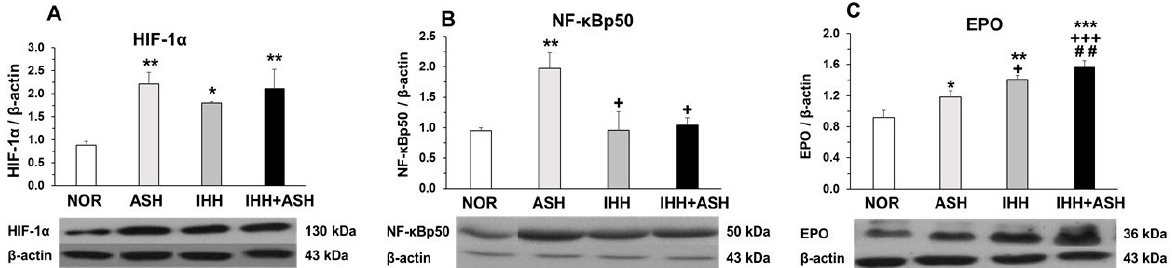
Figure 3. Transcriptional factors in response to hypoxia. Examples of Western blots bands normalized to β -actin (with each corresponding well) are shown. Units are expressed relative to the β -actin content. ( A ) HIF-1 α , hypoxia-inducible factor 1-alpha; ( B ) NF- κ Bp50, nuclear factor kappa-light-chain-enhancer of activated B cells; ( C ) EPO, erythropoietin. Statistically significant differences between groups are presented with asterisks (*, vs. NOR), crosses (+, vs. ASH) or hashtags (#, vs. IHH). One symbol indicates p < 0.05, two symbols p < 0.01 and three symbols p < 0.001. F-values after running one-way ANOVAs with Bonferroni’s post hoc multiple comparison tests were: F = 3.96 (HIF-1 α ), F = 1.01 (NF- κ Bp50) and F = 11.98 (EPO). Animal experimental groups are abbreviated as NOR, normoxic; ASH, acute severe hypoxia; IHH, intermittent hypobaric hypoxia; IHH+ASH, intermittent hypobaric hypoxia followed by acute severe hypoxia.